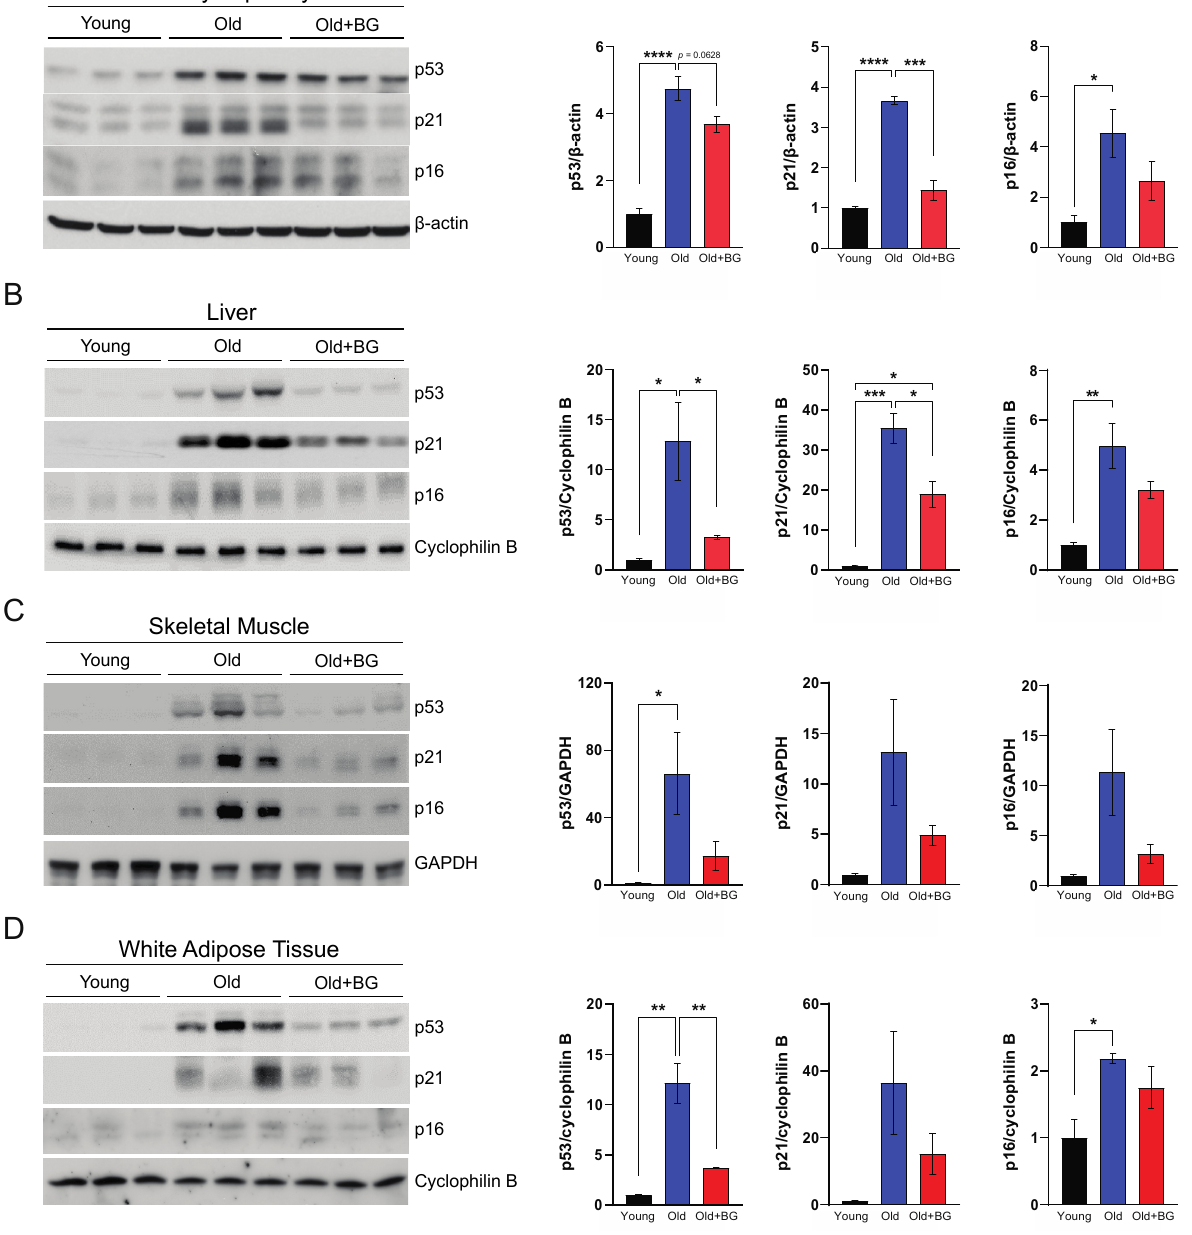
Figure 4. p53, p21, and p16 expression level in primary hepatocytes ( A ), liver ( B ), skeletal muscle (SKM) ( C ), and white adipose tissue (WAT) ( D ) (n = 3 mice per group). * p ≤ 0.05, ** p ≤ 0.01, *** p ≤ 0.001 and **** p ≤ 0.0001.